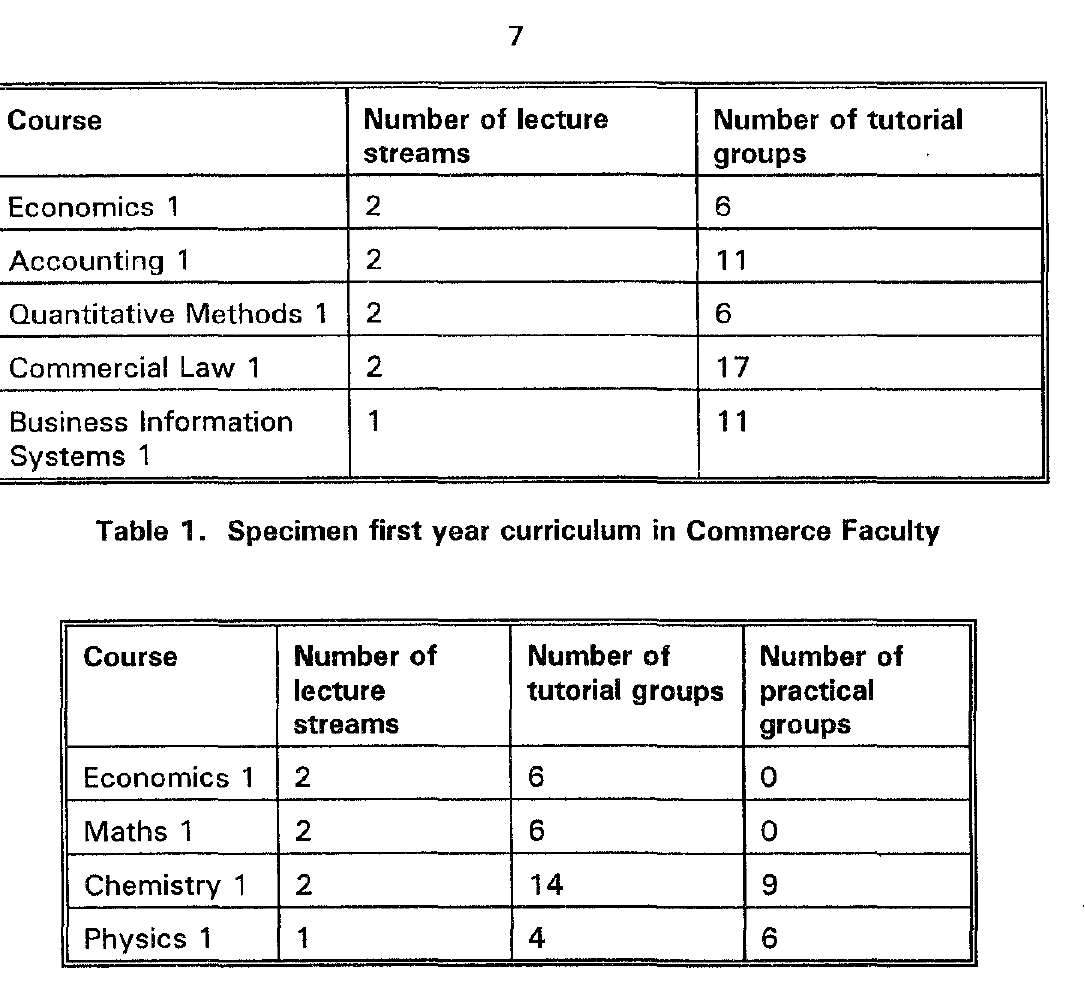
Table 2. Specimen first year curriculum in Science Faculty